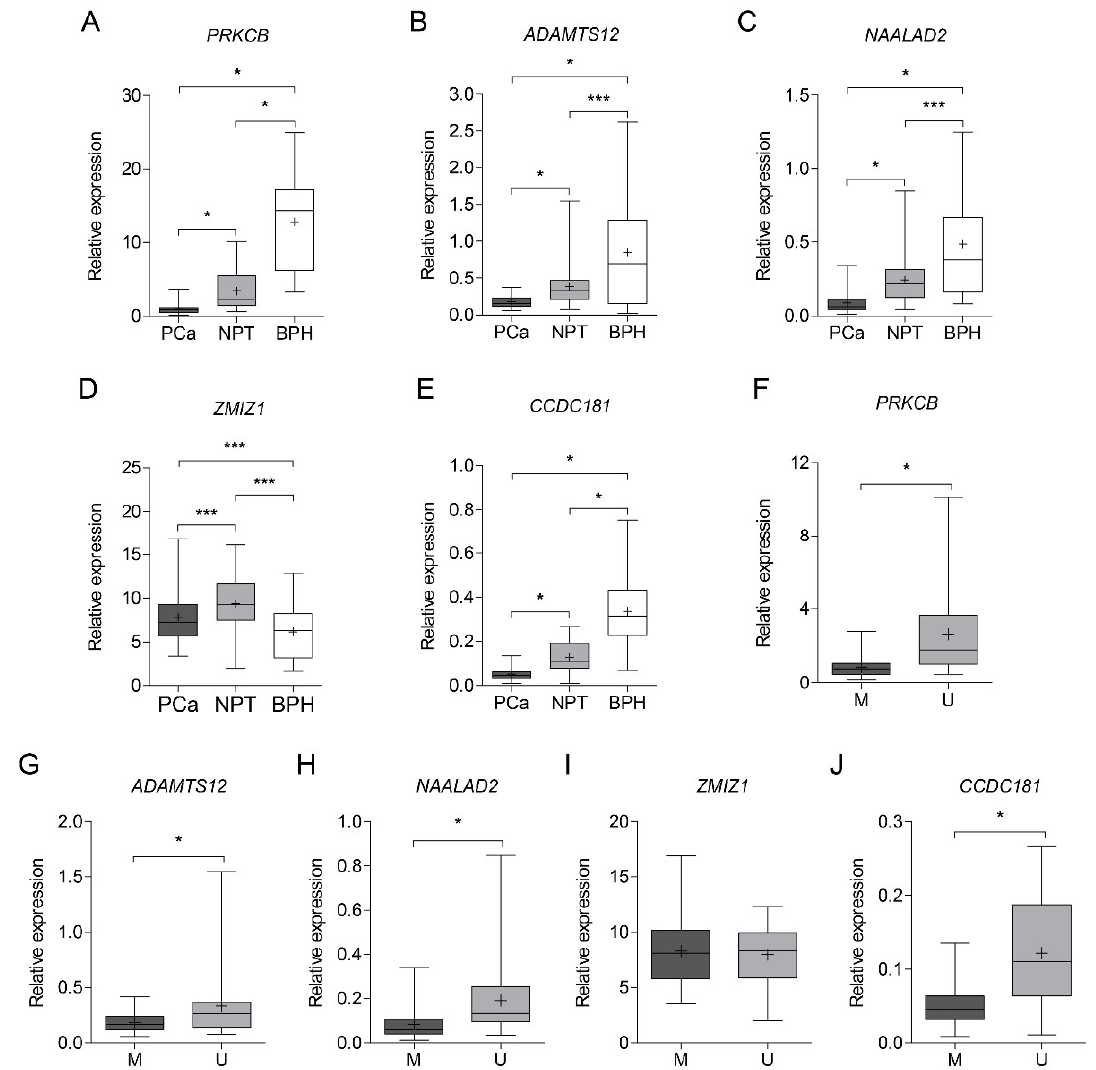
Figure 3. Expression of ADAMTS12 , CCDC181 , NAALAD2 , PRKCB, and ZMIZ1 in cancerous and noncancerous prostate tissue. ( A – E ) Relative expression of selected genes in prostate cancer (PCa), noncancerous prostate tissue (NPT), and benign prostatic hyperplasia (BPH) samples; ( F – J ) Relative expression of selected genes in PCa according to methylation status, i.e., methylated (M) or unmethylated (U; MSP data). The boxplot depicts Q1–Q3 quartile where the line in the box indicates the median and the plus sign indicates the mean. Significant p -values are marked in bold. *— p ≤ 0.0001, ***— p <